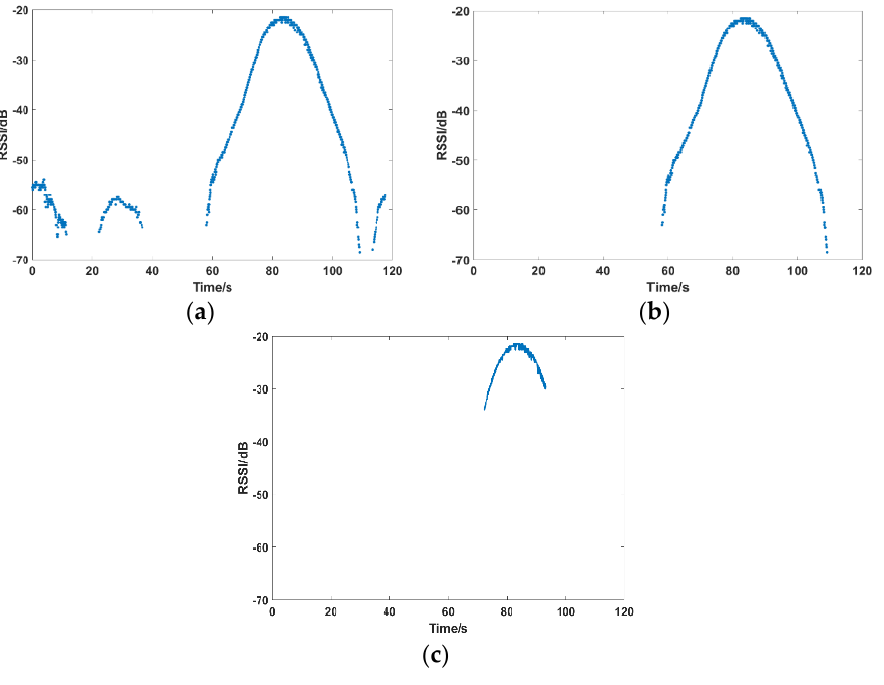
Figure 9. Data segmentation and interception. ( a ) Raw data; ( b ) After segmentation; and, ( c ) After interception.